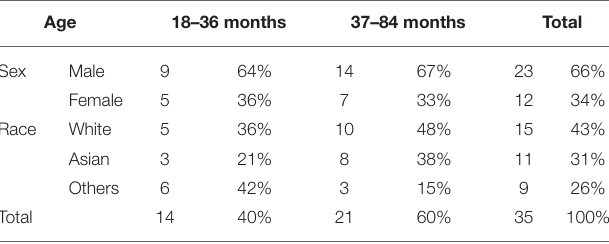
TABLE 1 | Demographic features of the participants by age, sex, and